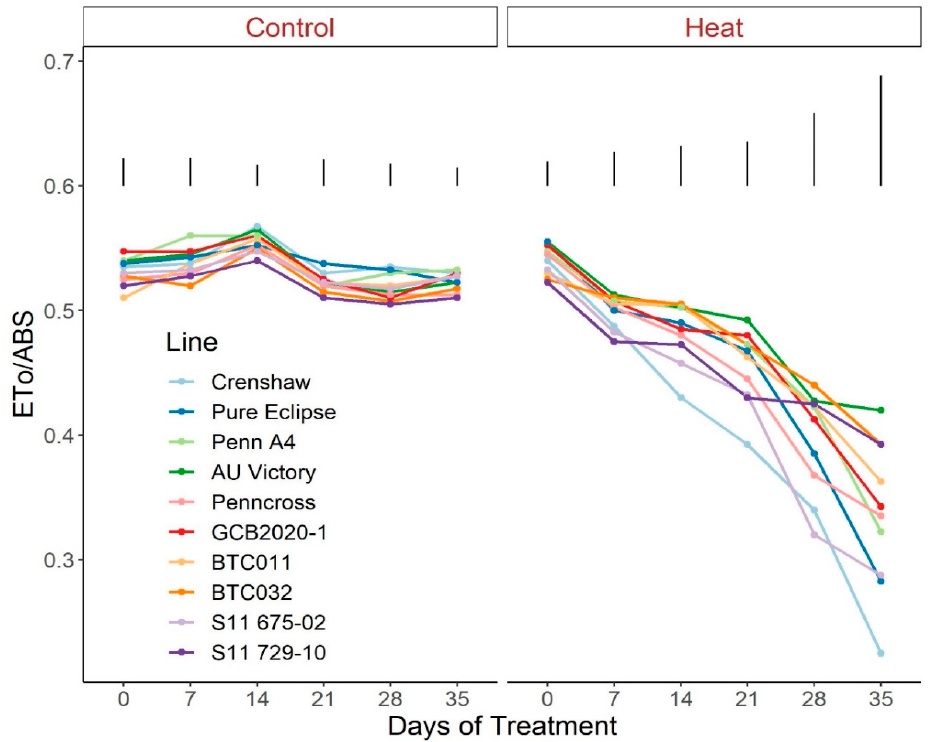
Figure 6. Change in Eto/ABS for creeping bentgrass lines over time under control (20/15 °C day/night) and heat stress (38/33 °C day/night) conditions. Bars represent LSD values at p = 0.05 on days when significant differences among lines were found.